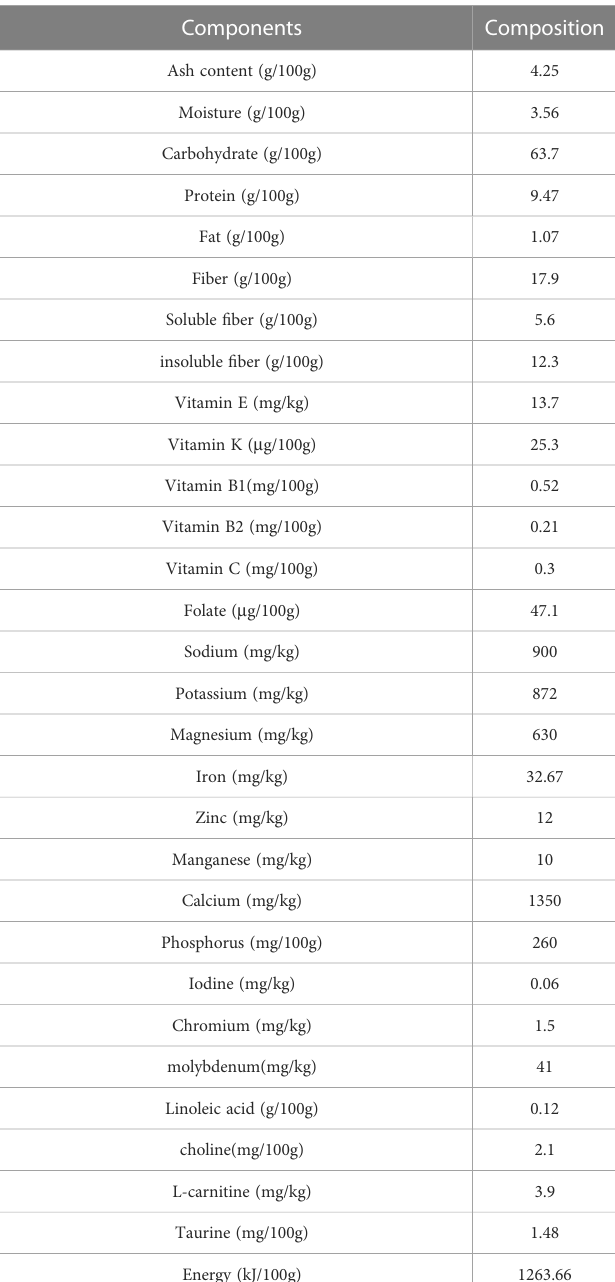
TABLE 1 The components of the high fi ber